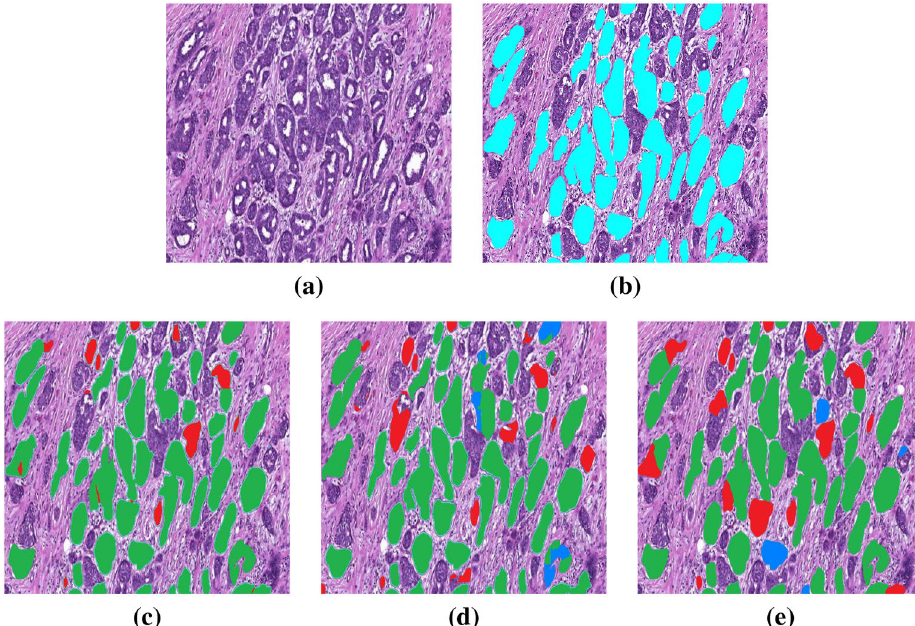
Figure 6. Qualitative results, ( a ) Cropped Image 3000 × 3000 from a WSI, ( b ) Ground truth, ( c ) EfficientNetB3-U-Net, ( d ) DenseNet161-U-Net, ( e ) ResNet34-U-Net. The segmentation results are shown as: Green, correct segmentation regions; Blue, non-segmented regions which must be segmented; Red, incorrectly segmented regions.